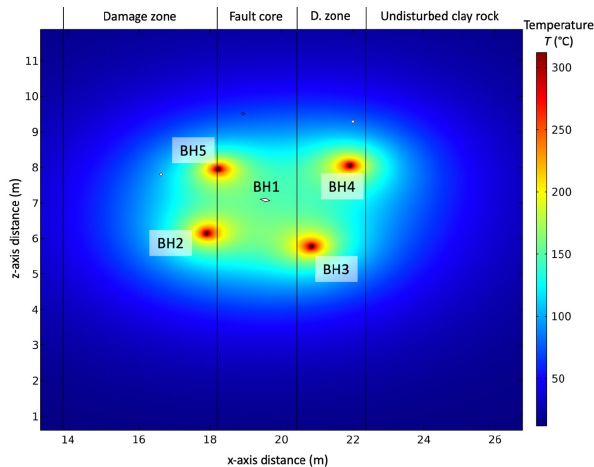
Figure 9. Temperature map on a plan in the x - z direction, zoom on the stimulated area. This section crosses the middle of the heaters of BH2 to 5 and BH1 (i.e., the blank spot) as indicated on the figure. The vertical black lines indicate the location of the damage zones surrounding the fault core as written at the top of the